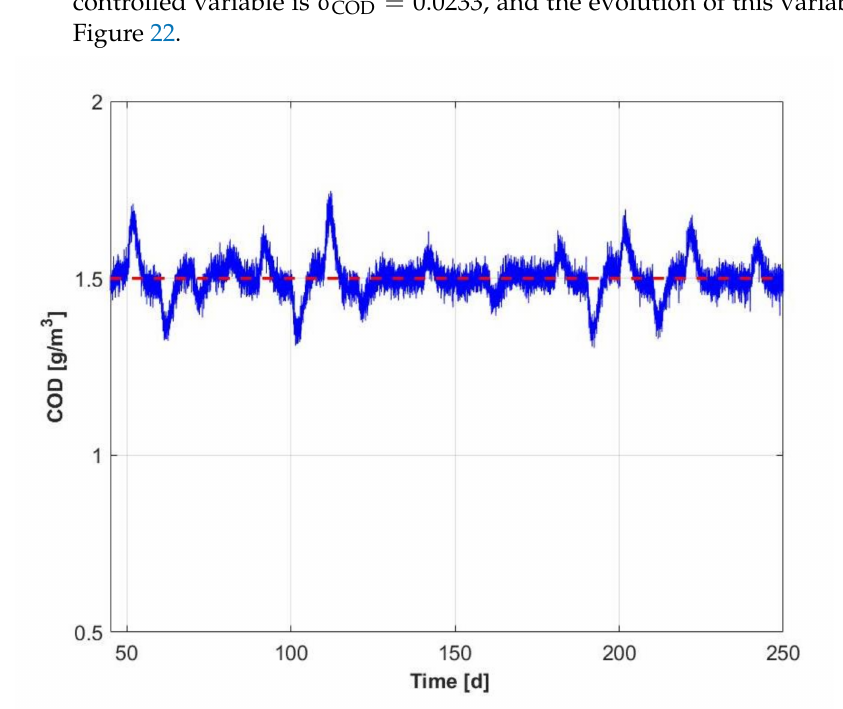
Figure 22. Effect of measurement noise on the controlled